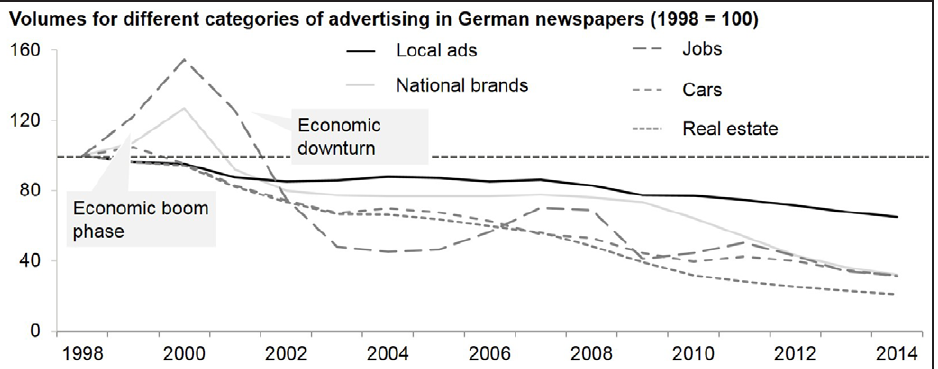
Figure 2: Development of advertising volumes (mm) for different categories. Source : Own calculations on the basis of raw data from ZMG